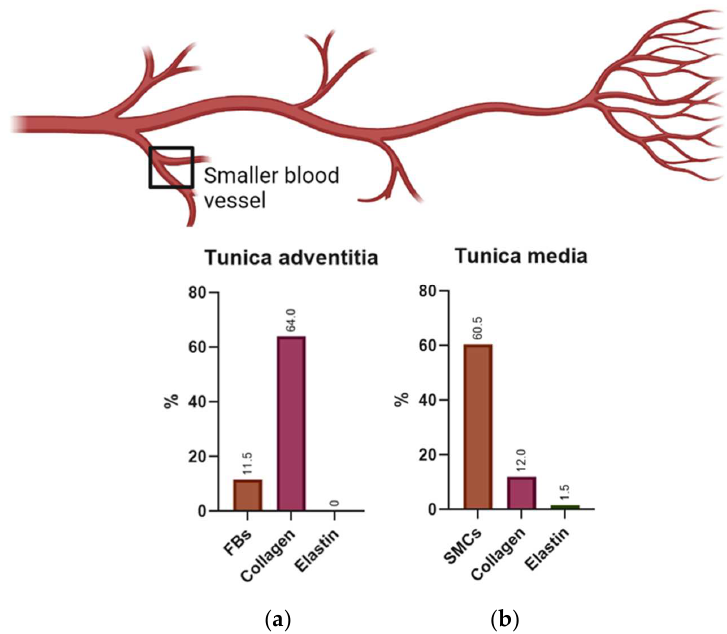
Figure 2. Component percentages on small-sized blood vessels for ( a ) tunica adventitia and ( b ) tunica media. Data from small-sized vessels retrieved from D.B. Camasão et al. [12]. Fibroblasts (FBs) and smooth muscle cells (SMCs). Image created with BioRender.com and graph constructed with GraphPad Prism (accessed on 29 May 2022).